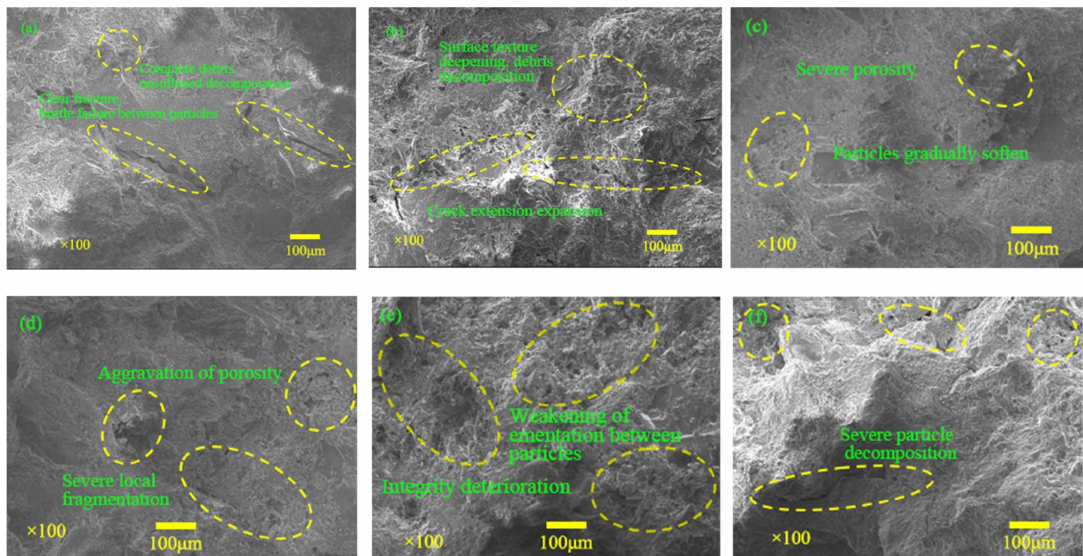
Figure 6. Meso-structural characteristics of sandstone with different saturations under freeze–thaw